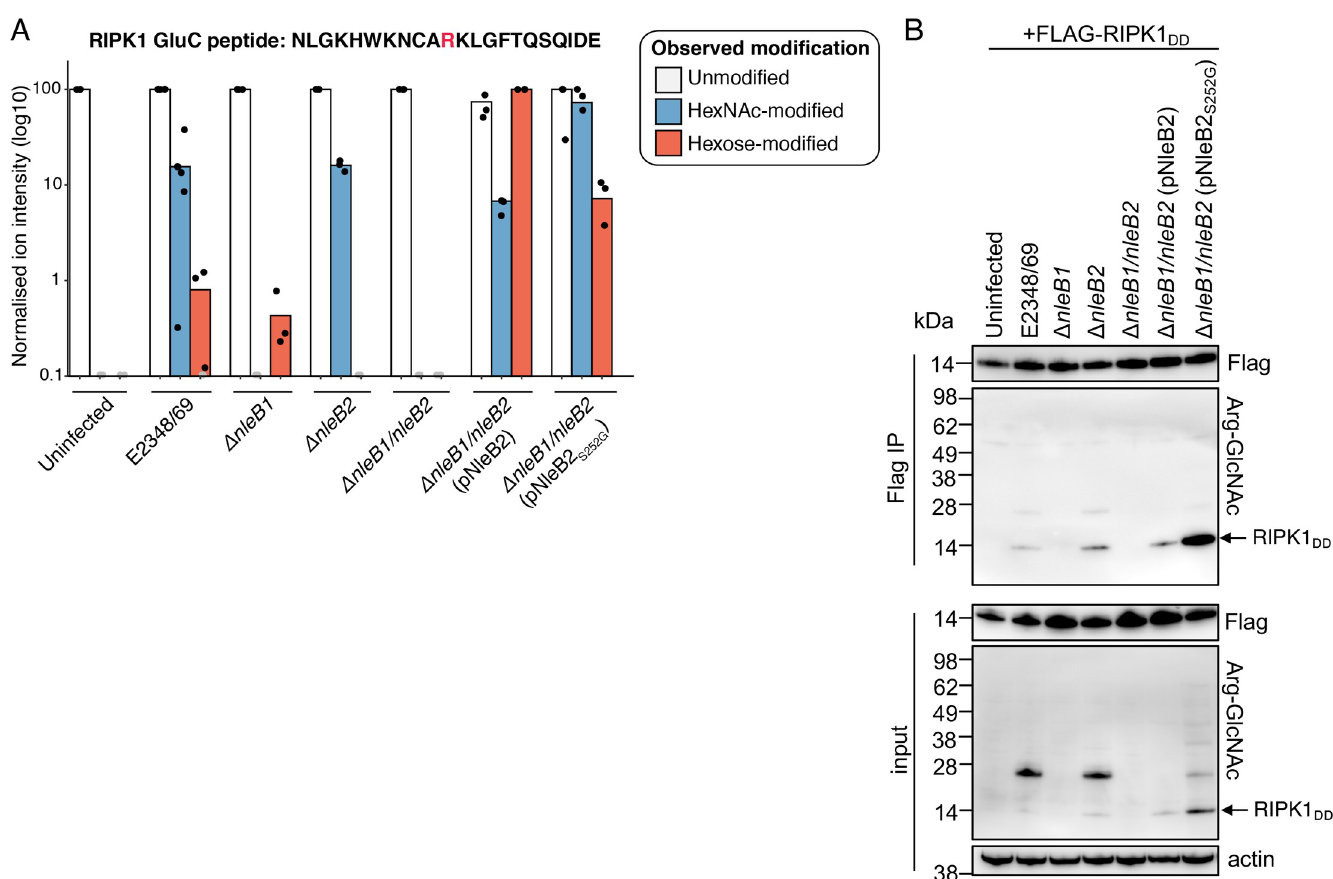
Fig 8. Arginine glucosylation of RIPK1 during EPEC infection. HEK293T cells were transfected with pFlag-RIPK1 DD before being infected with derivatives of EPEC E2348/69 for 3 hours. Anti-Flag immunoprecipitation was performed on cell lysates and eluates were subjected to mass spectrometry (A) or immunoblot analysis (B) . (A) Normalised ion intensities of the peptide forms of NLGKHWKNCARKLGFTQSQIDE identified in Flag-RIPK1 DD immunoprecipitated from EPEC-infected HEK293T cells. Results are shown as log10 of ion intensities normalised to the most abundant peptide form identified in each condition. Black points represent the peptides detected in each replicate, and grey points indicate that the peptide was not detected within the replicate. Combined data from at least 3 independent experiments for each condition. (B) Immunoblot analysis of input and eluate (Flag IP) of Flag-RIPK1 DD immunoprecipitated from EPEC-infected HEK293T cells. Membranes were probed with anti-Flag or anti-Arg-GlcNAc. Anti-Actin antibodies were used as a loading control. Representative of at least 3 independent experiments.